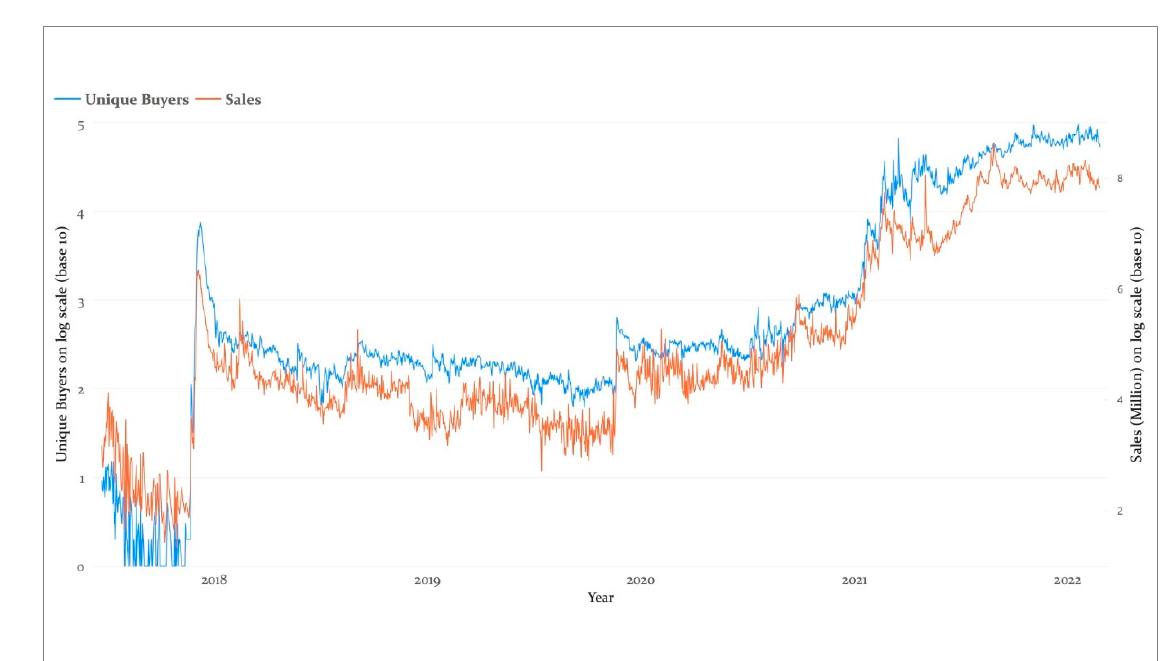
Figure 1. NFT Index from CryptoSlam (As of 25 February 2022).